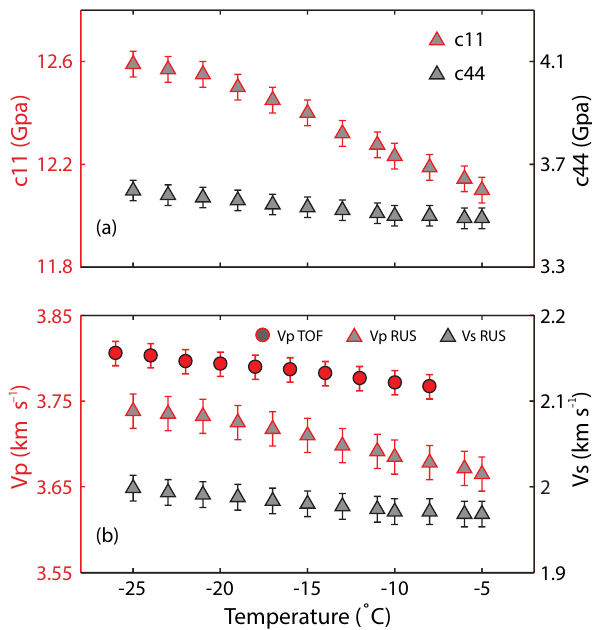
Figure 5. Estimates of the elastic constants c 11 and c 44 from RUS as a function of temperature (a) . Estimates of V p and V s from RUS are compared to V p estimated from travel-time measurements (b) . The elastic constants are compared on the same vertical scale, as are V s and V p